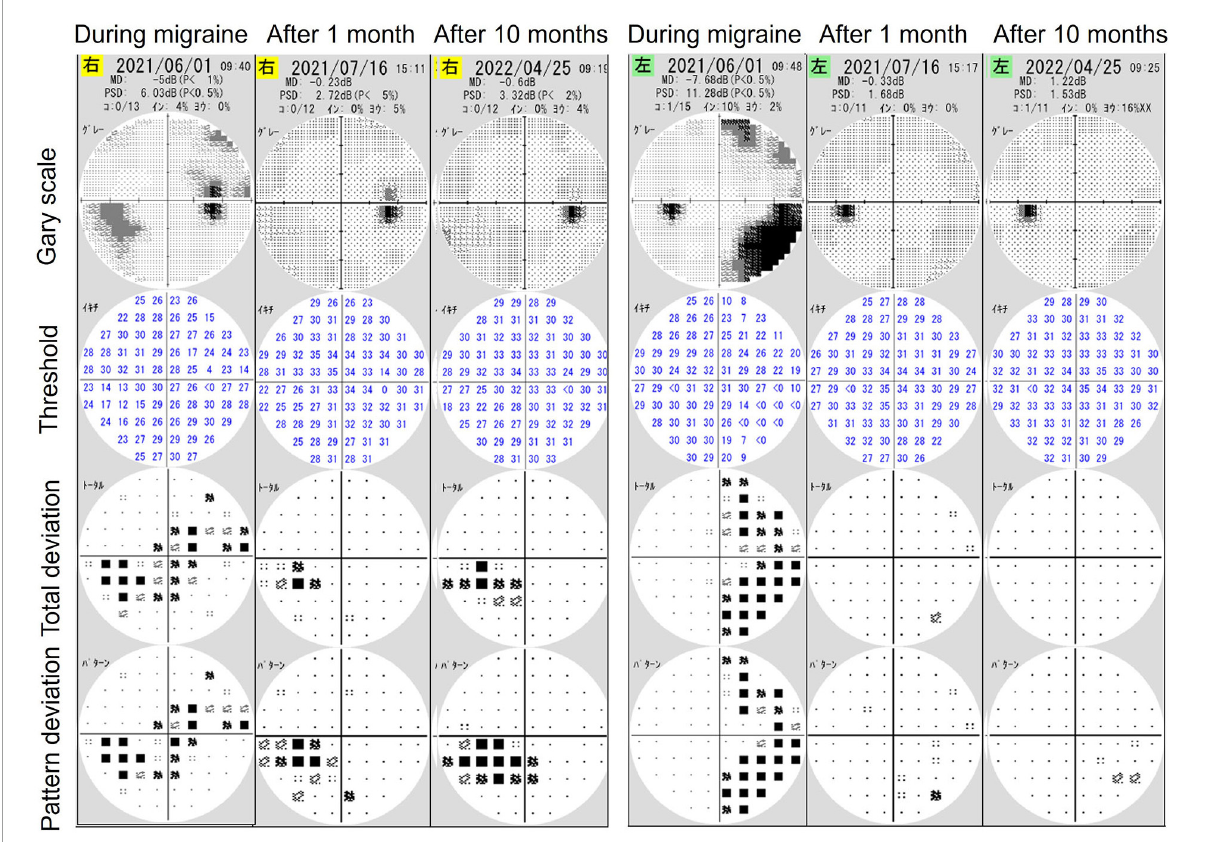
FIGURE3 The results of visual field examinations using a Humphrey field analyzer (HFA) 1 and 10 months after initial HFA examination during a migraine attack. Follow-up findings revealed only glaucomatous visual field defects in the right eye without right-sided homonymous hemianopia-like visual field